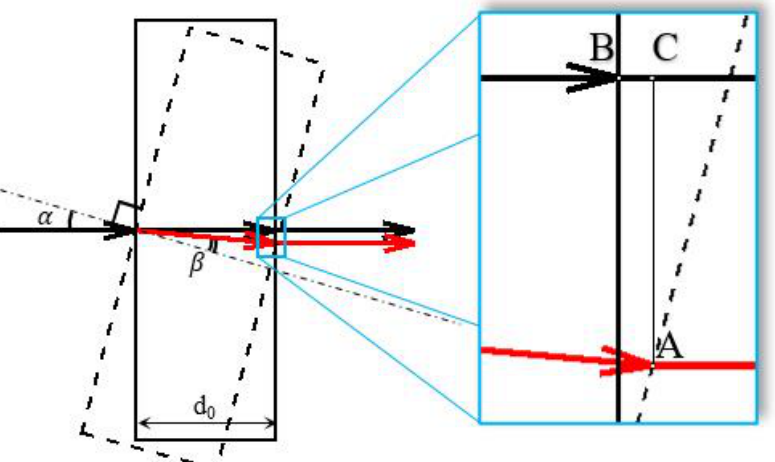
Figure 1. Path difference in plane-parallel plate. α is the PPP rotational angle, the black arrow is the light path with α = 0, the red arrow is a light path with α (cid:54) = 0, d 0 is the PPP thickness, and β is the angle of refraction. Zoomed inset shows the detailed location of the shifted light path because of PPP